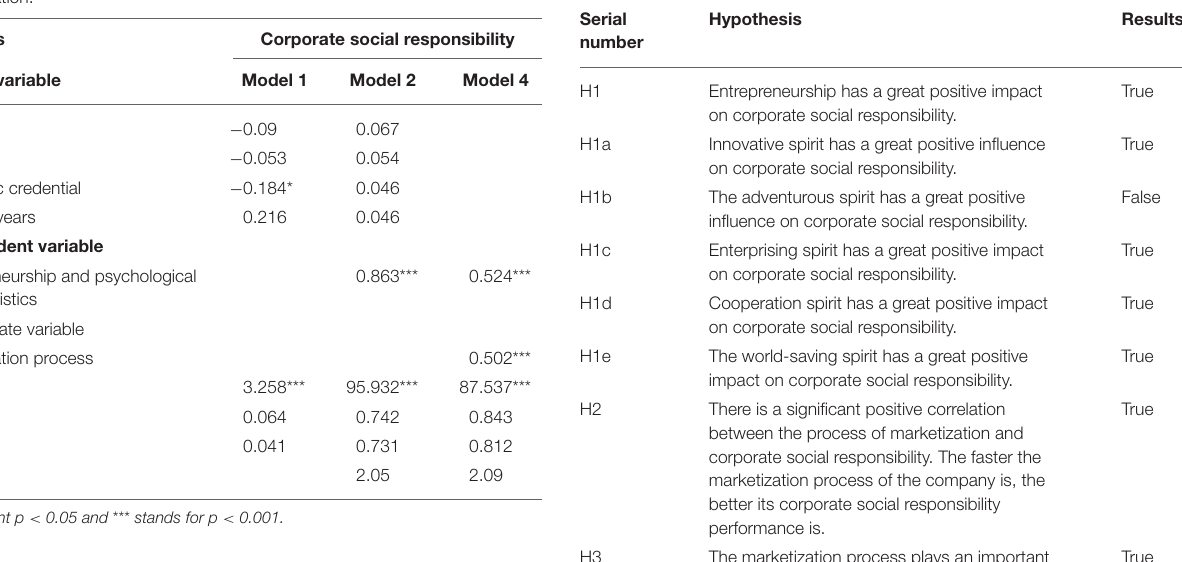
TABLE 4 | The results of regression analysis of the intermediary effect of marketization.